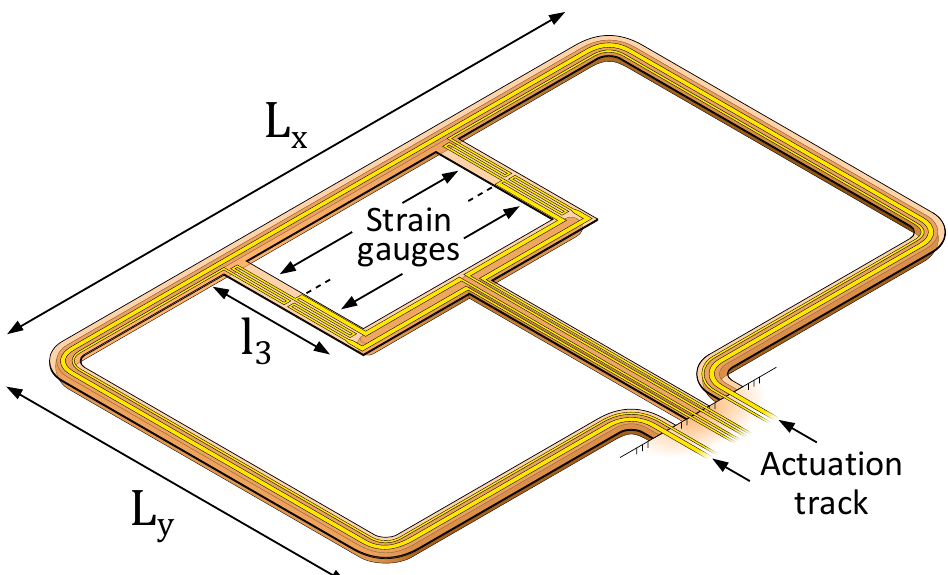
Figure 7. Design C: A T-junction channel structure is connected through two membranes to the main channel loop. Four strain gauges reside on the membranes with length l 3 . Two experience elongate, while the other two experience